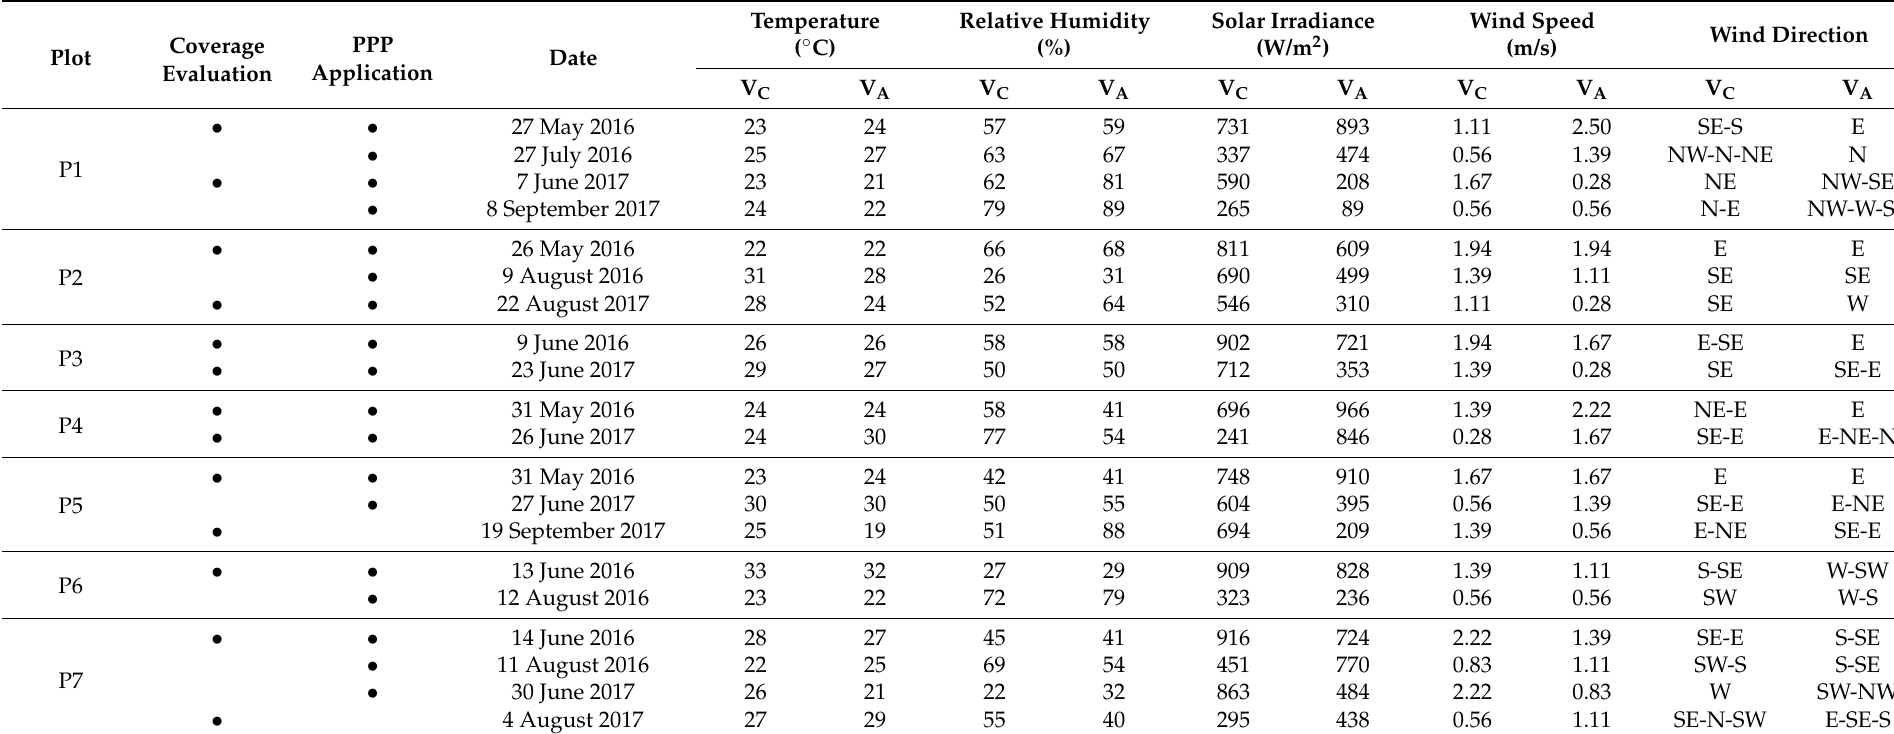
Table A2. Meteorological conditions 1 during the spray applications and coverage evaluations: temperature, relative humidity, solar irradiance, wind speed, wind direction and precipitation 2 .